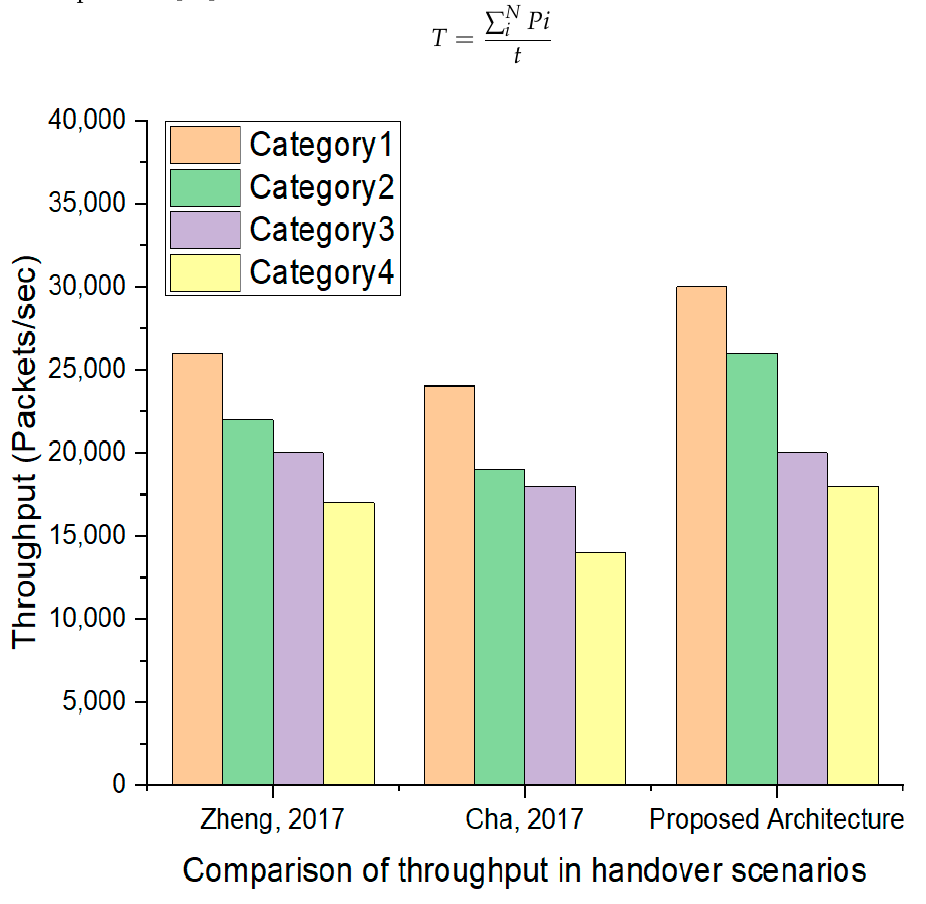
Figure 8. Throughput comparison of proposed scheme with [25] (Zheng, 2017) and [26] (Cha, 2017).